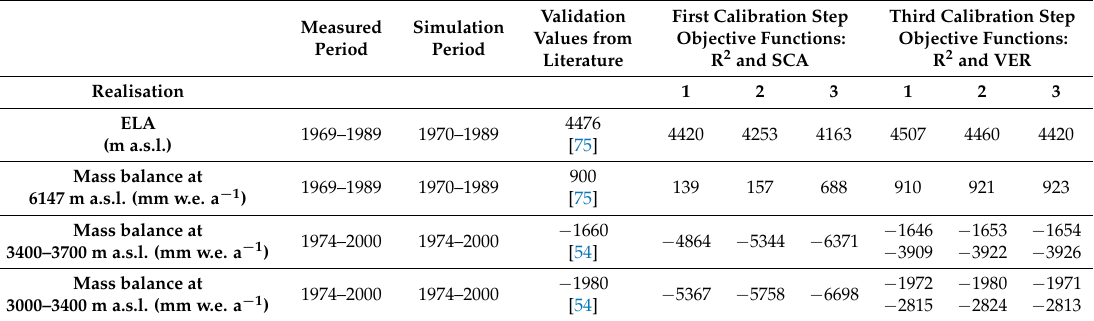
Table 4. Additional data of first and second automatic calibration (REMO, Period 1). Mass balances are given in mm water equivalent per year (mm w.e. a − 1 ). Grey: Mass balance calculation without debris cover.